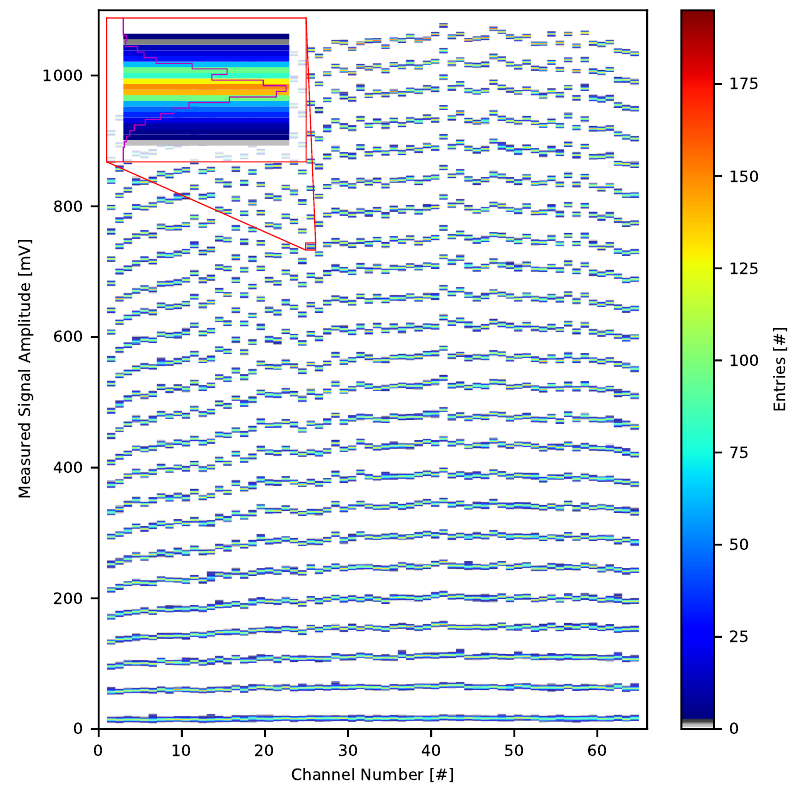
Figure 18. Measured signal amplitude distribution for gain setting g = 250 and stimulation output current from 11nA to 649nA with a step of 28nA. Each amplitude was recorded 1000 times for all of 64 Neurostim-3 ASIC